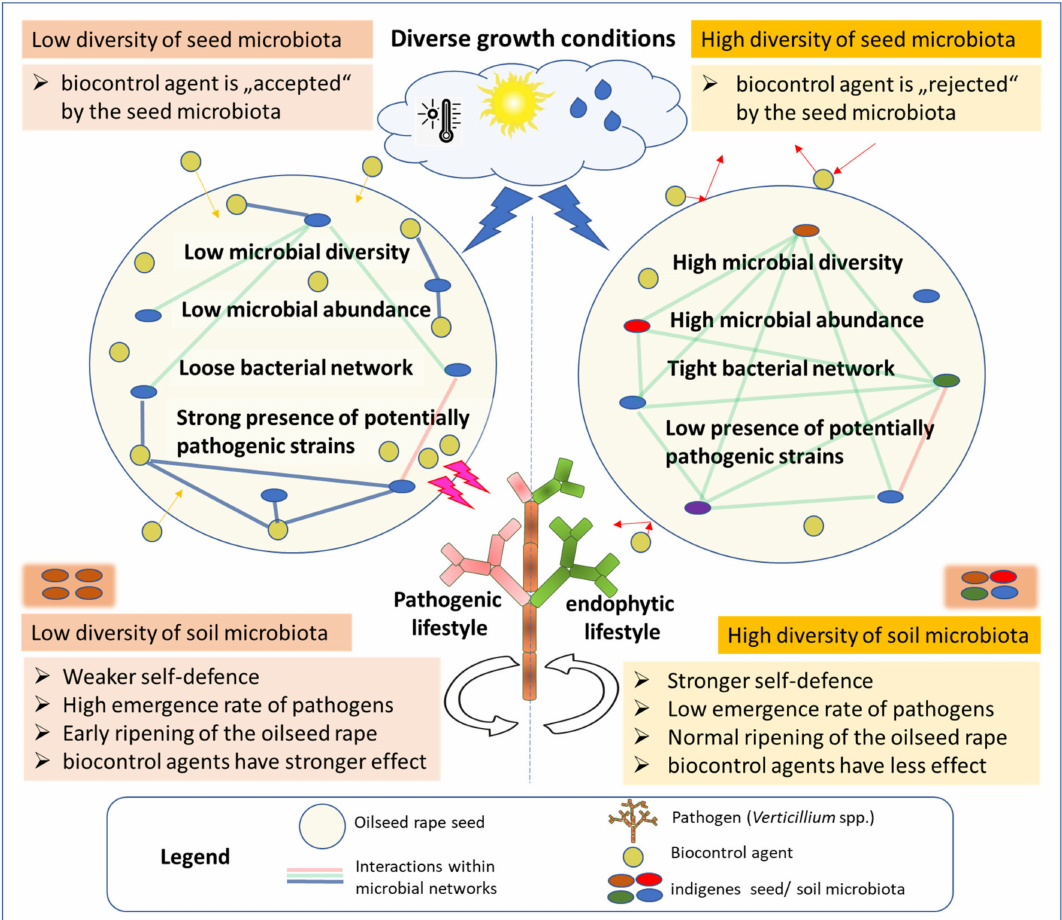
Figure 2. Microbiome interactions and disease outbreaks and